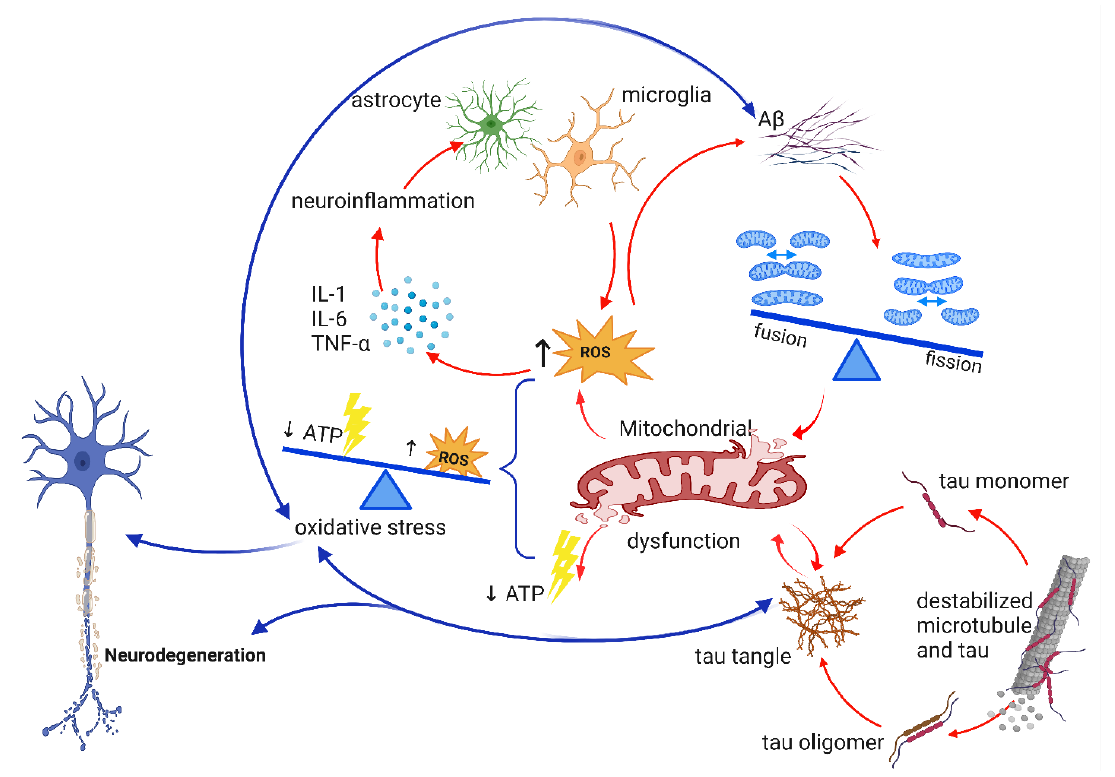
Figure 4. Production of Aβ alters the equilibrium between mitochondrial fusion and fission, leading to mitochondrial malfunction. Through the generation of ROS, mitochondrial malfunction causes an increase in Aβ production, starting a vicious cycle. Increased ROS levels increase the production of cytokines, including TNF-α, IL-1, and IL-6, which leads to neuroinflammation. On the other hand, inflammatory responses cause microglia and astrocytes to become highly active and generate high levels of ROS. Tau pathology and growing mitochondrial dysfunction are a vicious loop that affects synaptic and neuronal function. Created with BioRender (BioRender.com).